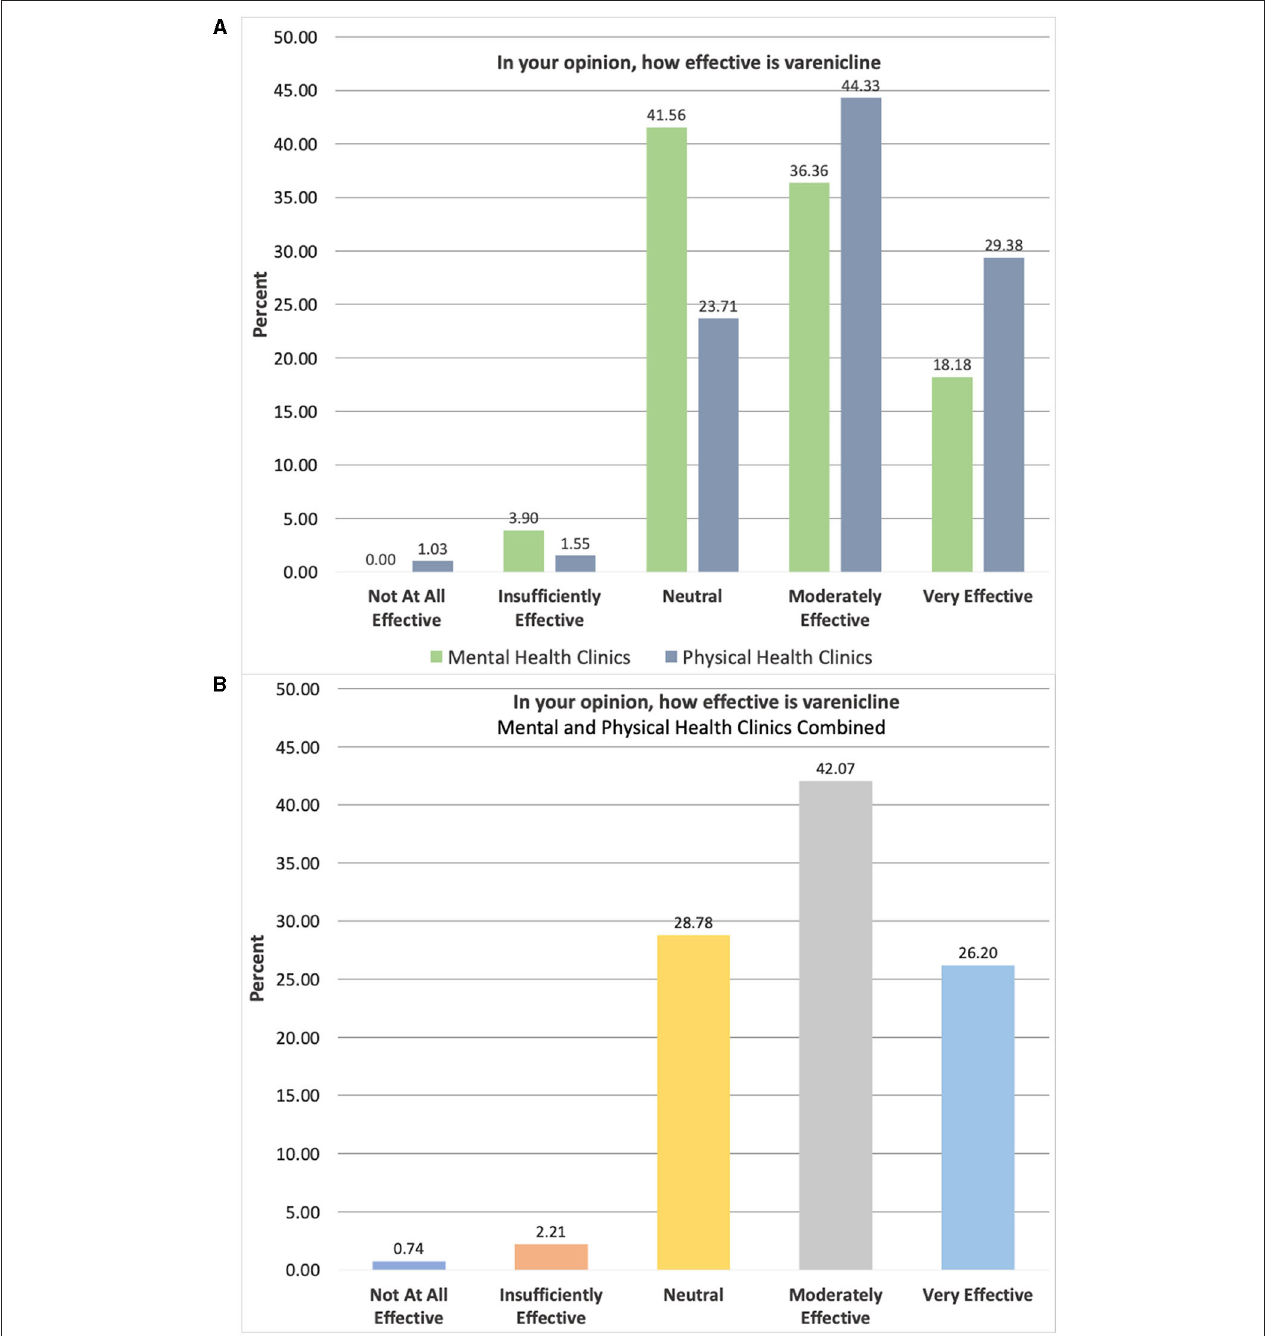
FIGURE 1 | Breakdown of provider belief responses by clinic for varenicline efficacy. Items rated on 5-point Likert scale ranging from “Not At All Effective” (1) to “Very Effective” (5); (A) Physical Health Clinics = Department of Health Services: n = 194, Mental Health Clinics = Department of Mental Health: n = 77; (B) Clinics combined N =